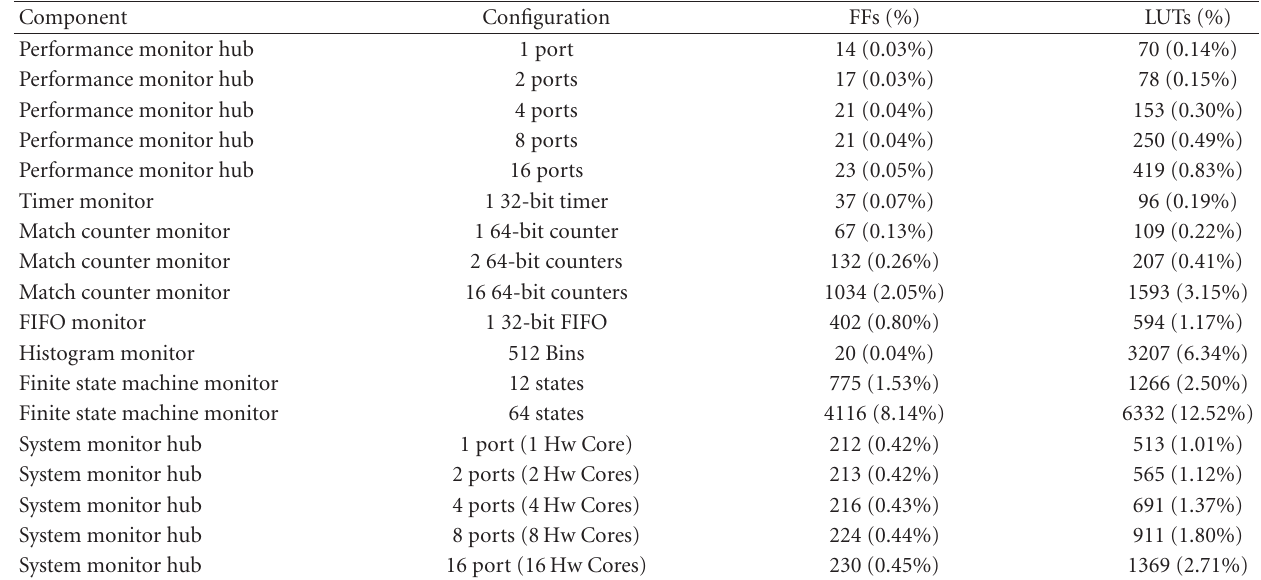
Table 2: Example of HwMPI’s resource utilization on